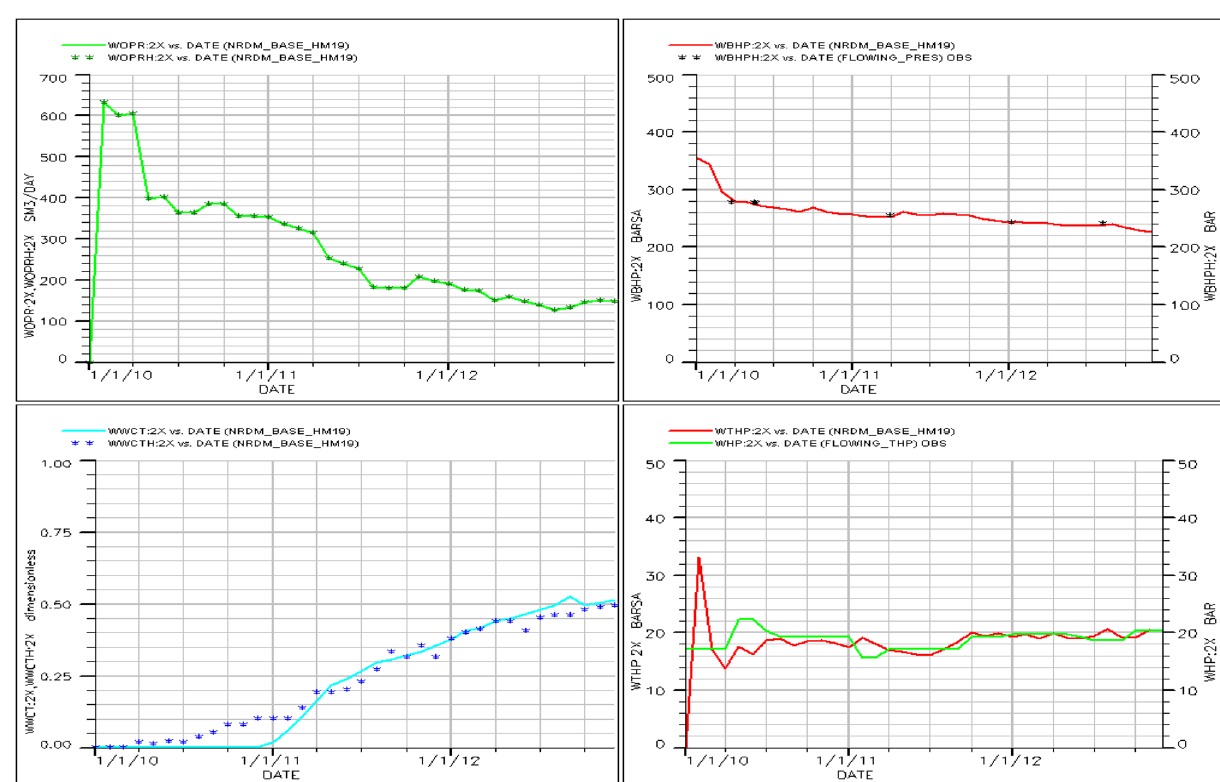
Fig. 7 Matching results of